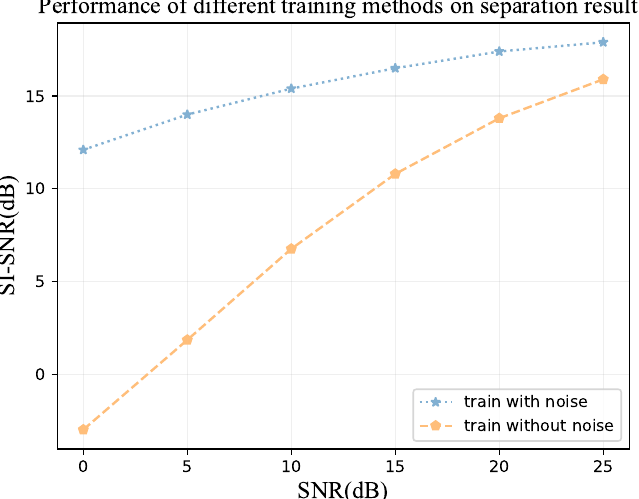
Figure 10. In the case of training with noise and training without noise, different SI-SNRs were obtained when inputting audio with different SNRs during validation. When training with noise, the input audio mixes the noise and the mixed species bird sound with a random SNR of 0–25